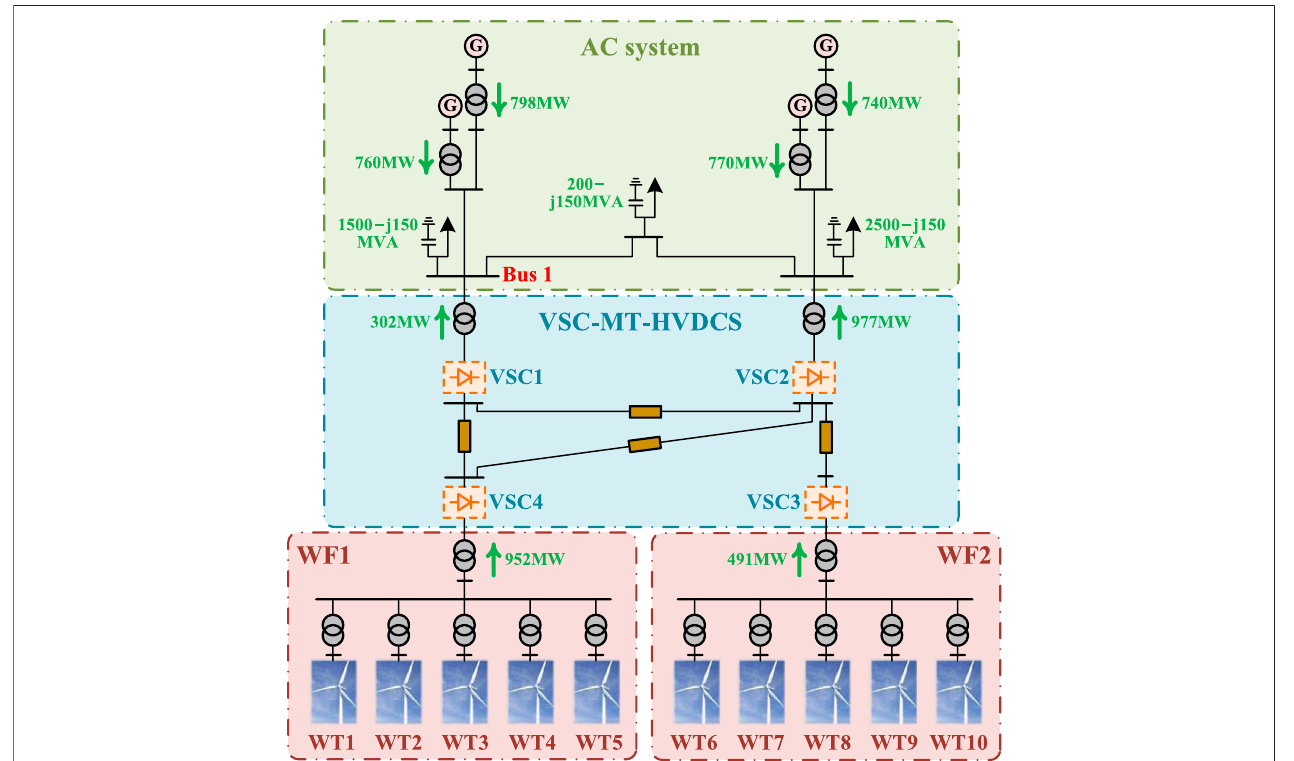
FIGURE 2 | Schematic diagram of test system: A three-area four-terminal VSC-MT-HVDC-based WFs and AC system.